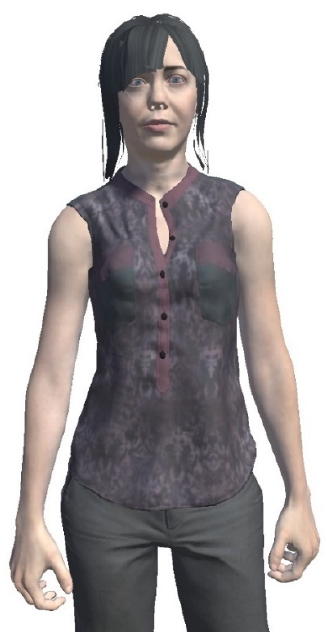
Figure 5. The first iteration of the VA as it appears in Unity 3D.